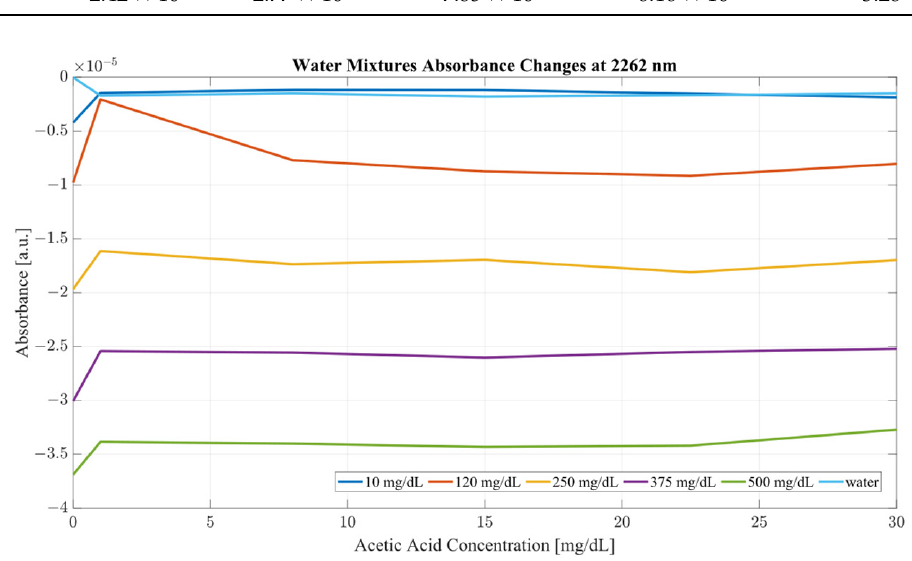
Figure 6. Water mixture absorbance changes at 2262 nm.